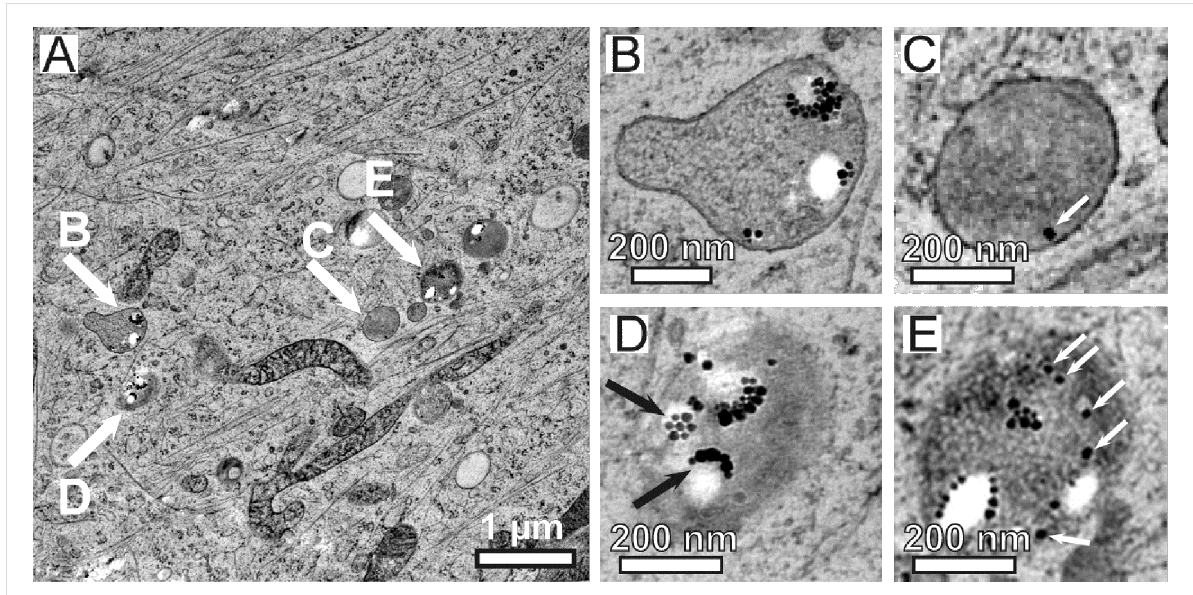
Figure 5: TEM bright field micrograph showing an overview (A) of a thin section of a MSC after 24 h of incubation with magnetite-decorated PLLA nanoparticles. Enlargement of endosomes, which contain extracellular material such as magnetite or PLLA are shown in (B–E).